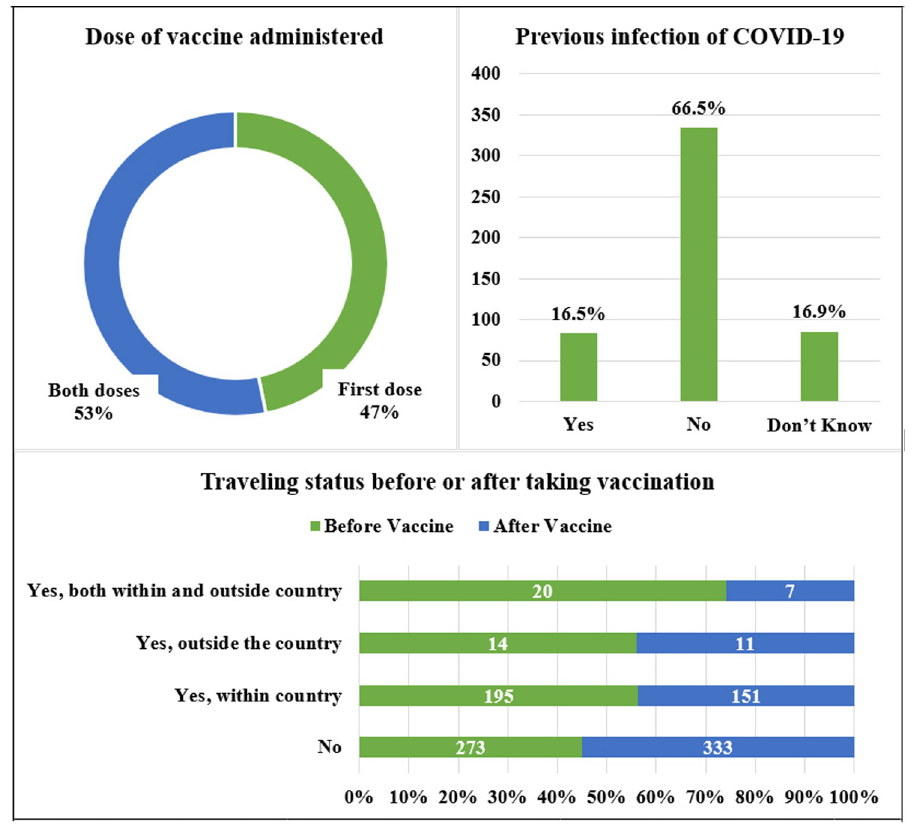
Fig 1. Current vaccine status, past occurrence of COVID-19, and traveling history of